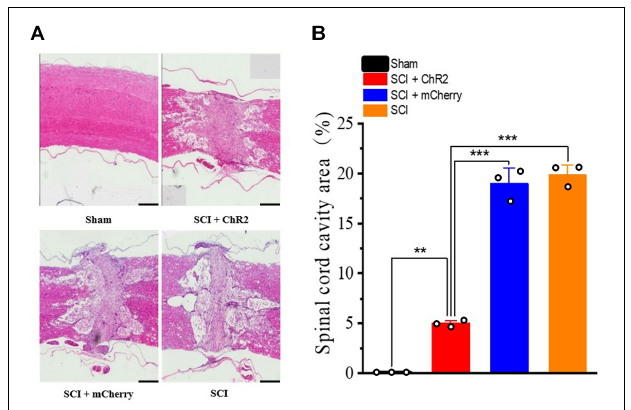
FIGURE 5 | Accurate stimulation of glutamatergic neurons in the M1 region promotes injured tissue recovery after spinal cord injury in rats. (A) The comparison chart of HE stained tissue sections of the four groups of rats at the 6th week (500 µ m/bar). (B) The histogram of the injury area of each group of spinal cord injury. [**indicates P < 0.01, ***indicates P < 0.001, n = 3 rat/group, using one-way ANOVA. Data are shown as means (bar graphs) and standard error of the mean (error bars), with individual data points indicated as